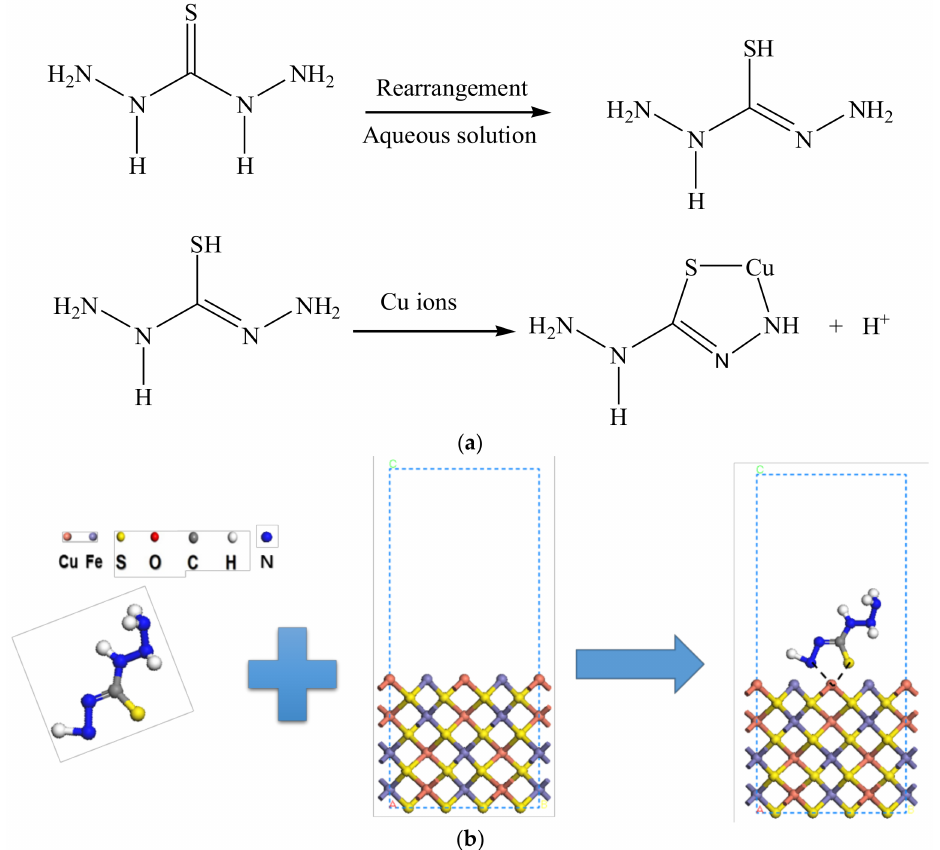
Figure 11. ( a ) Rearrangement of functional group NH 2 –NH–C(–SH)=N–NH 2 and formation of complexes on chalcopyrite surface; ( b ) proposed chemisorption model of TCH on chalcopyrite